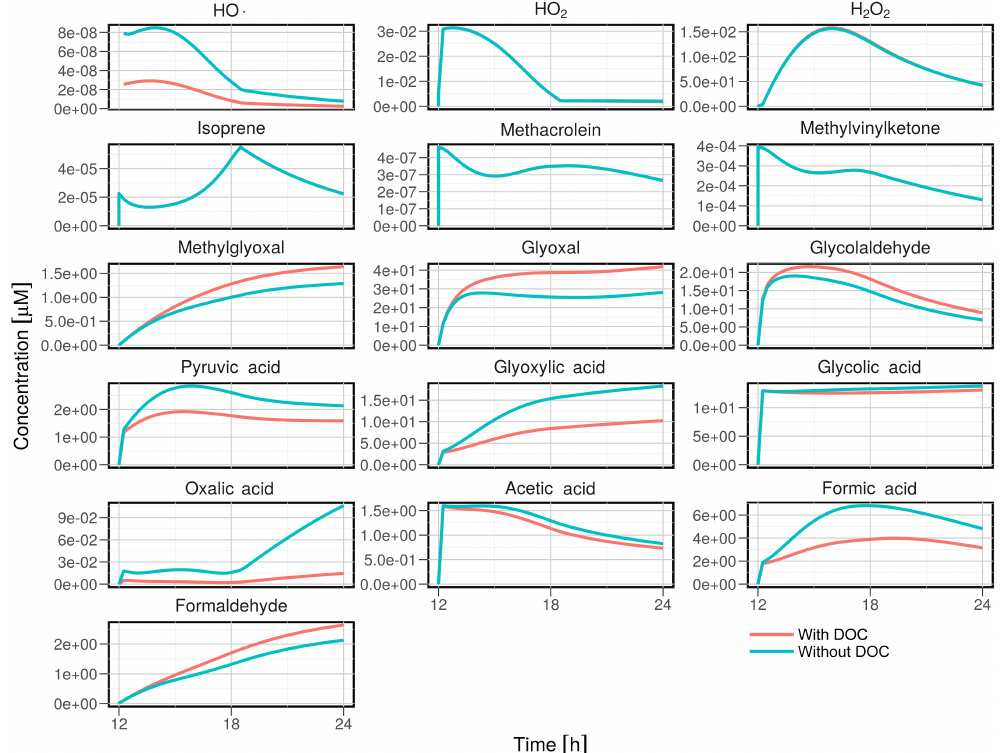
Figure 4. Time evolution of the dissolved species concentrations during the simulated cloud with (red lines) and without (blue lines) DOC. The vertical scale is in µM; therefore, the HO · radical concentrations are in the 10 − 14 M range. Please note that for some plots, the red line is hidden by the blue